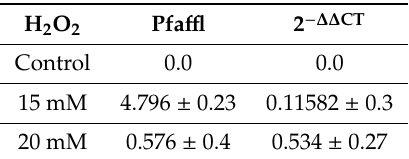
Table 4. The expression ratio and fold change of rbcL gene expression by using RT-PCR technique. The data are presented in means (±SE).